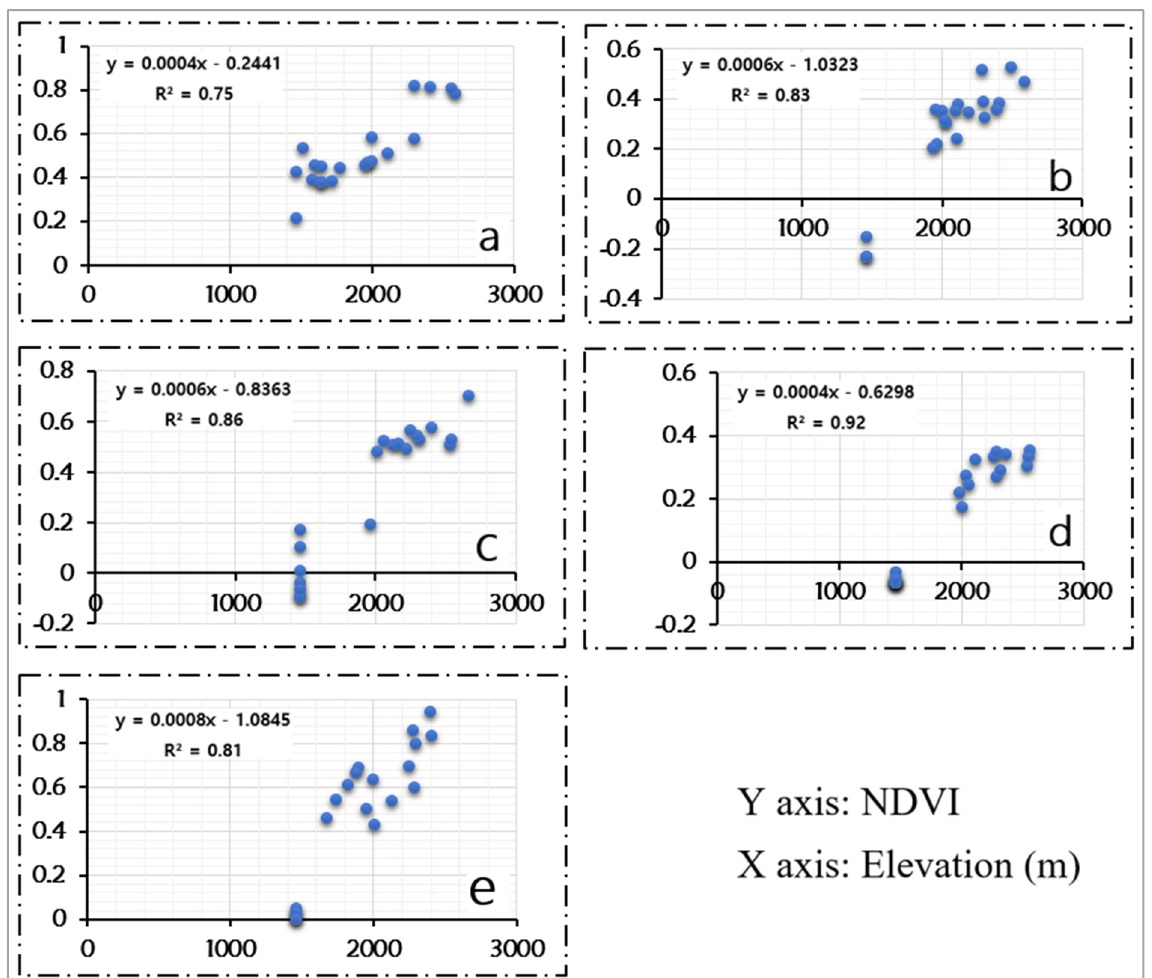
Figure 8. The relationships between NDVI and elevation for different considered years: ( a ) 2000, ( b ) 2005, ( c ) 2010, ( d ) 2010 and ( e ) 2018.